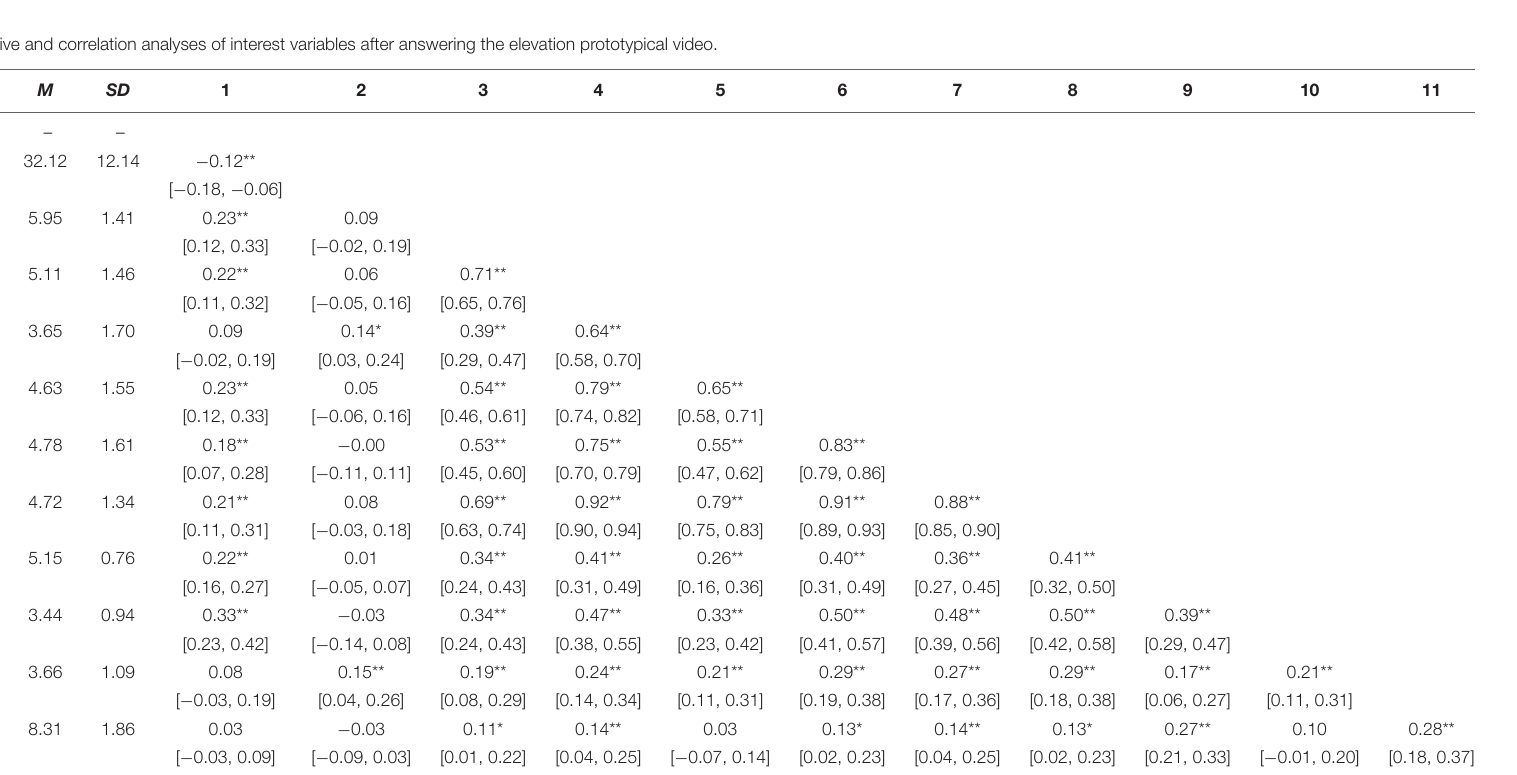
M and SD are used to represent mean and standard deviation, respectively. For Gender, 1 = Male, 2 = Female. Phys. response, physiologic response; Cog-sub. resp., cognitive-subjective response; Act. tend., action tendency; S-trans. Values, self-transcendent values. Values in square brackets indicate the 95% confidence interval for each correlation. * indicates p < 0.05. ** indicates p <